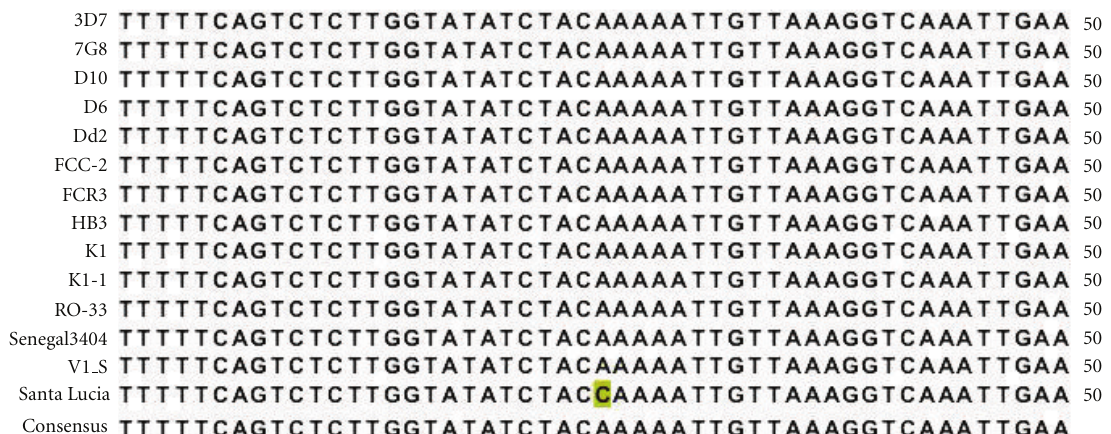
Figure 5: DNA sequence alignment of P0 across P. falciparum strains showing one synonymous mutation (marked in yellow) in the Santa Lucia strain. The rest of the sequences were identical across strains.